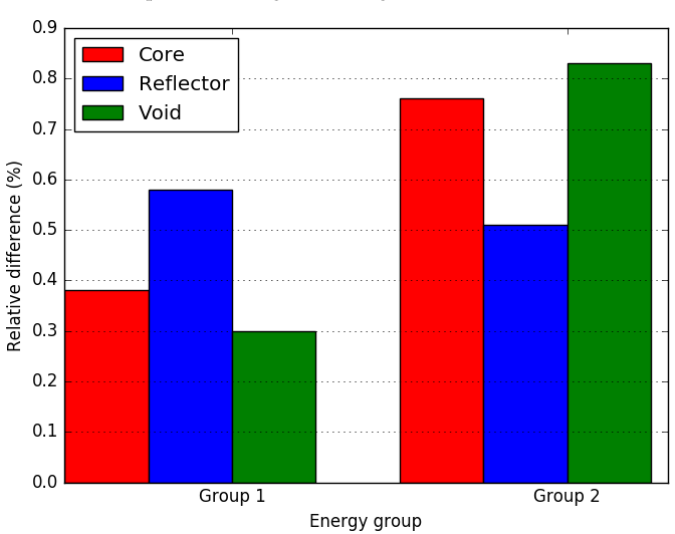
Figure 8. Comparison of region-averaged flux from reference and Parafish Model 1 Case 2.